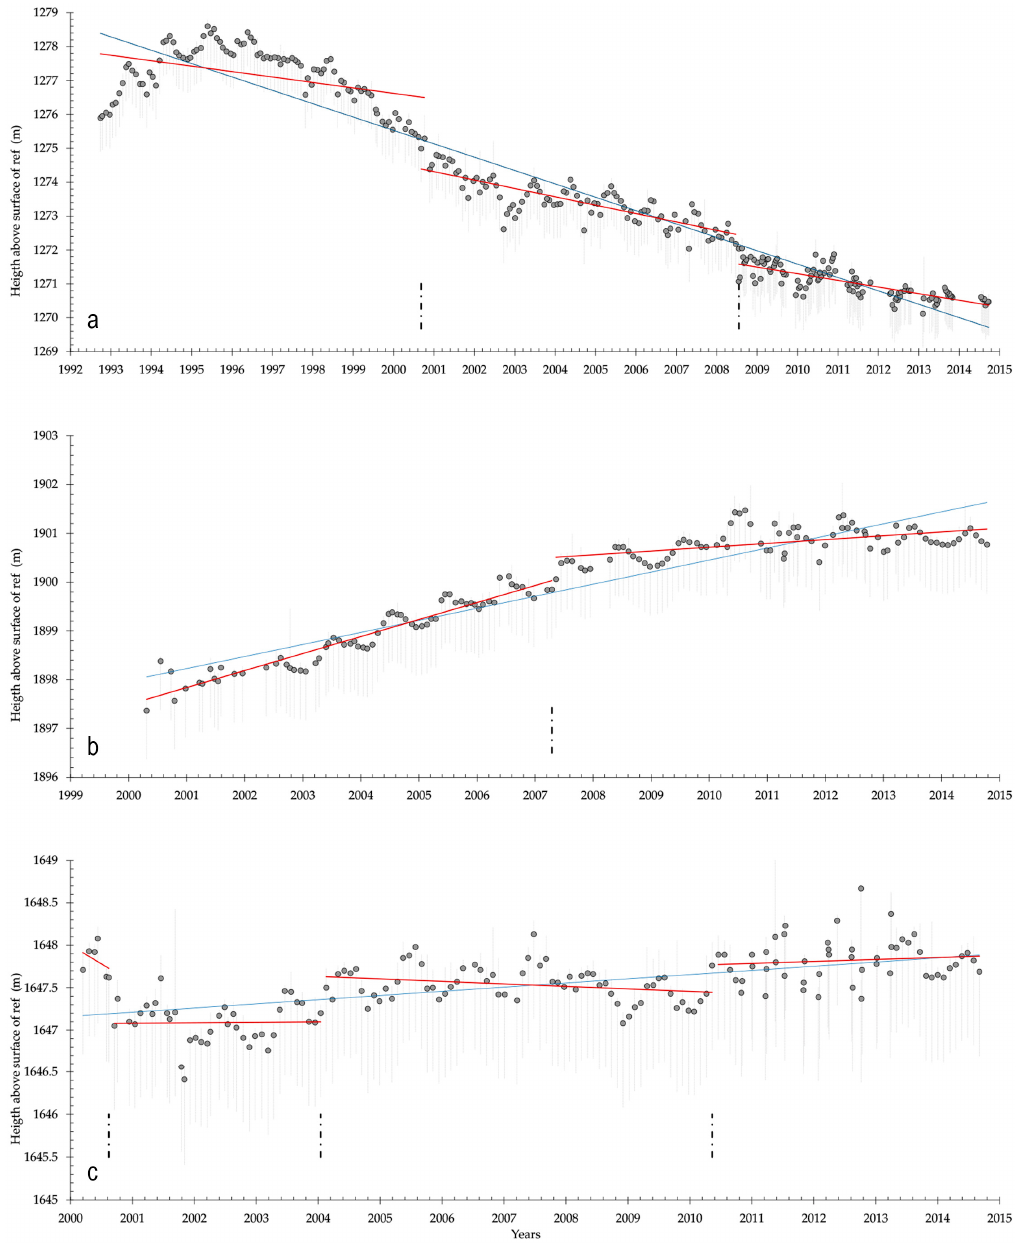
Figure 7. Time series of height above reference surface variations of: ( a ) Urmia Lake area between 1992 and 2011; ( b ) Lake Sevan area between 2002 and 2015; and ( c ) Van Lake area between 2002 and 2015 extracted from radar altimetry data.